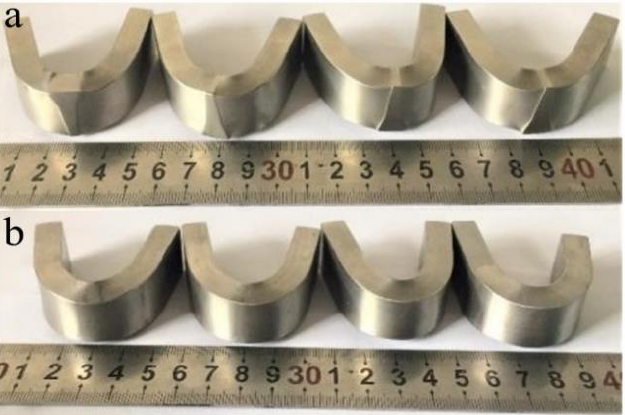
Figure 10. Bending test samples; ( a ) samples after test under welding condition, and ( b ) samples after test under quenching and tempering condition.